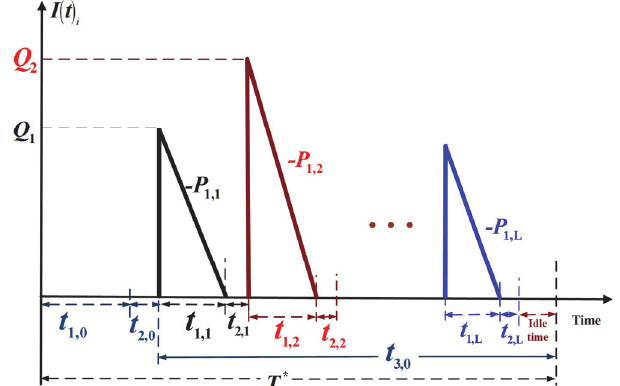
Fig. 4. The inventory status of common